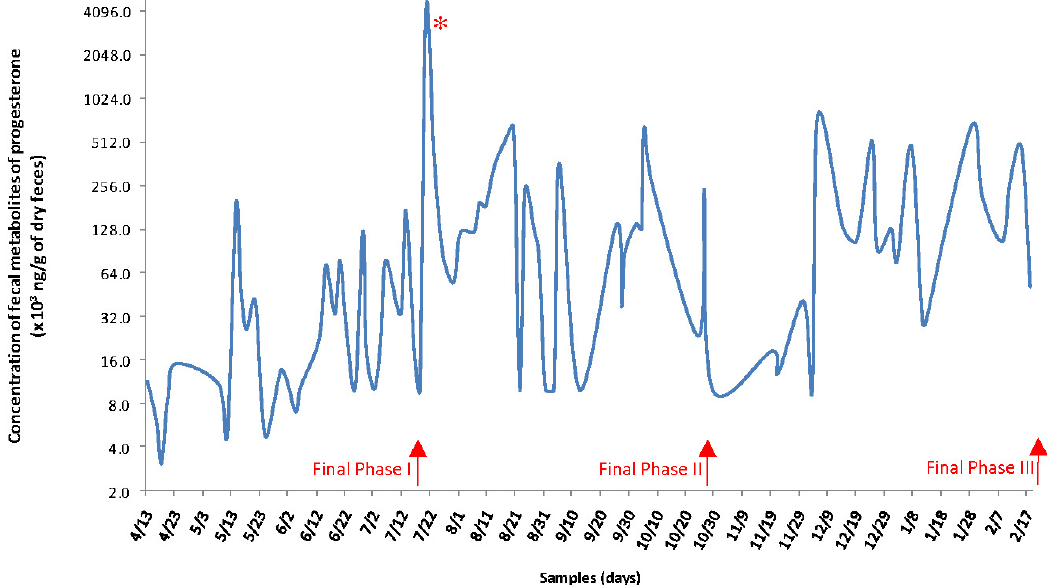
Figure 1. Exemplary female from the Deslorelin Group; Progesterone Metabolite Concentration during: Phase I - pre-implant; Phase II - implant; and Phase III - post-implant; * marking the initial stimulus